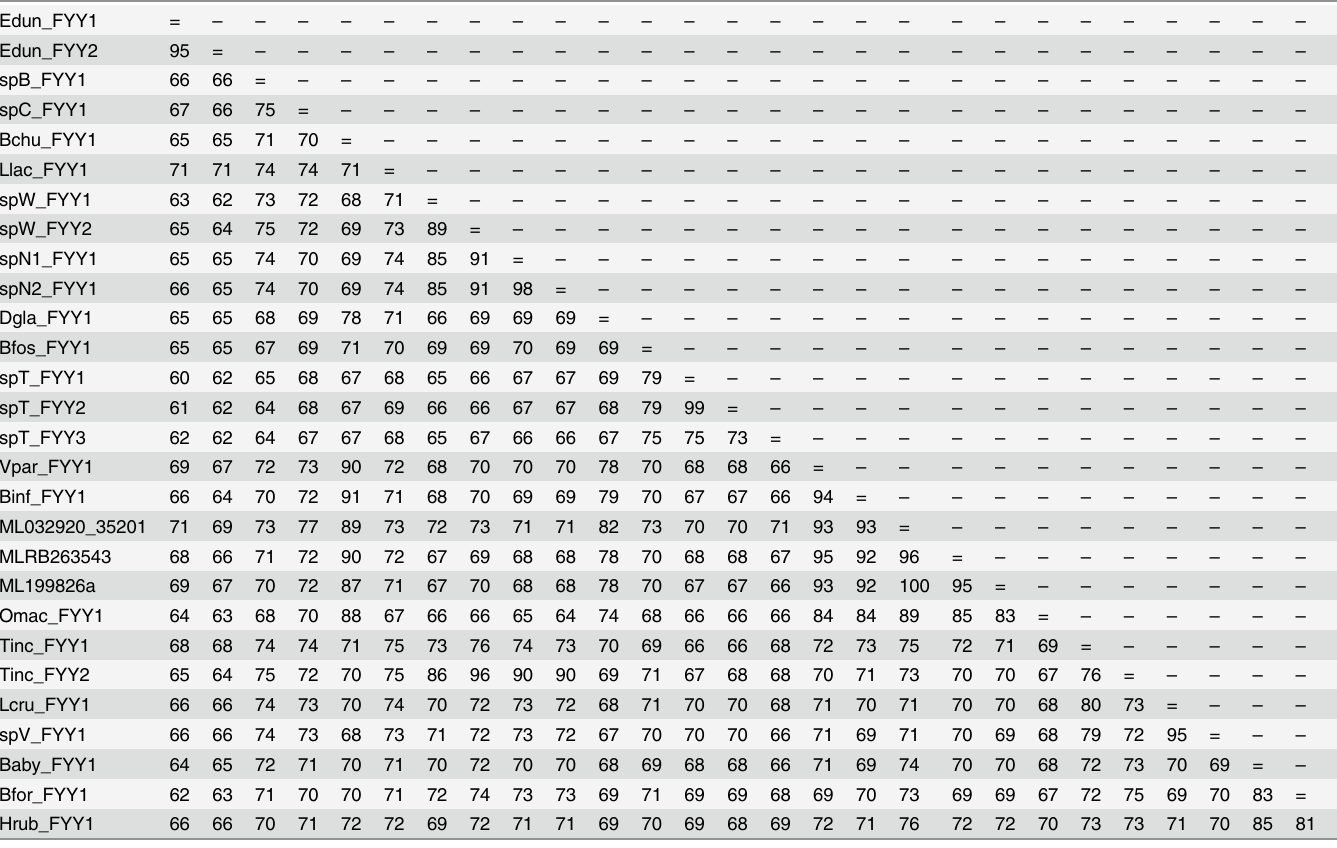
Table 5. Percent Identity Matrix of all FYY